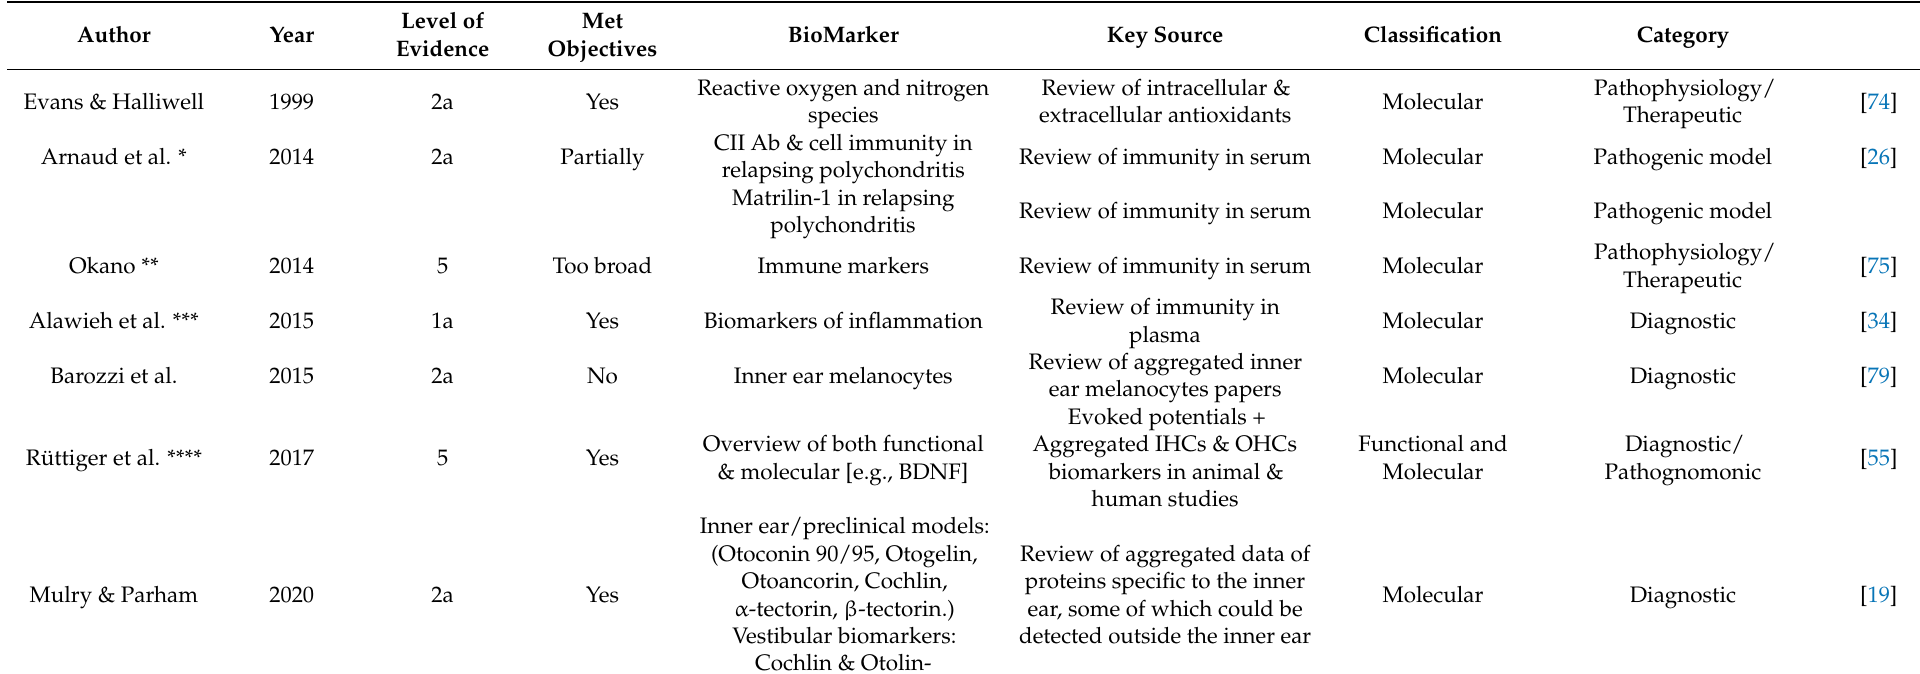
Table 3. Review articles of biomarkers related to the inner